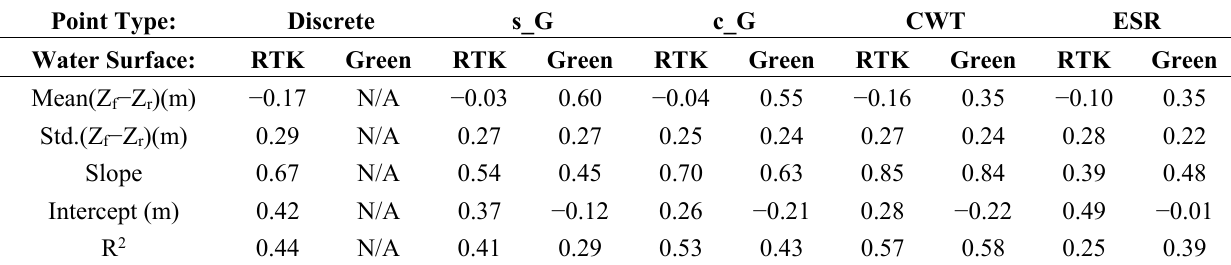
Figure 12. Comparison of LiDAR depth to ADCP depth for the Blue/Colorado River (( top ) LiDAR depths generated with RTK estimated water surface, ( bottom ) LiDAR depths with green return water surface). Black lines in the figures are the 1:1 lines while the red lines are regression lines, ( a ) water depths from discrete points; ( b ) water depths from s_G points; ( c ) water depths from c_G points; ( d ) water depths from CWT points; and ( e ) water depths from ESR points. Table 4. Comparison of LiDAR retrieved water depths to field measured ADCP water depths for the Blue/Colorado River. Results in